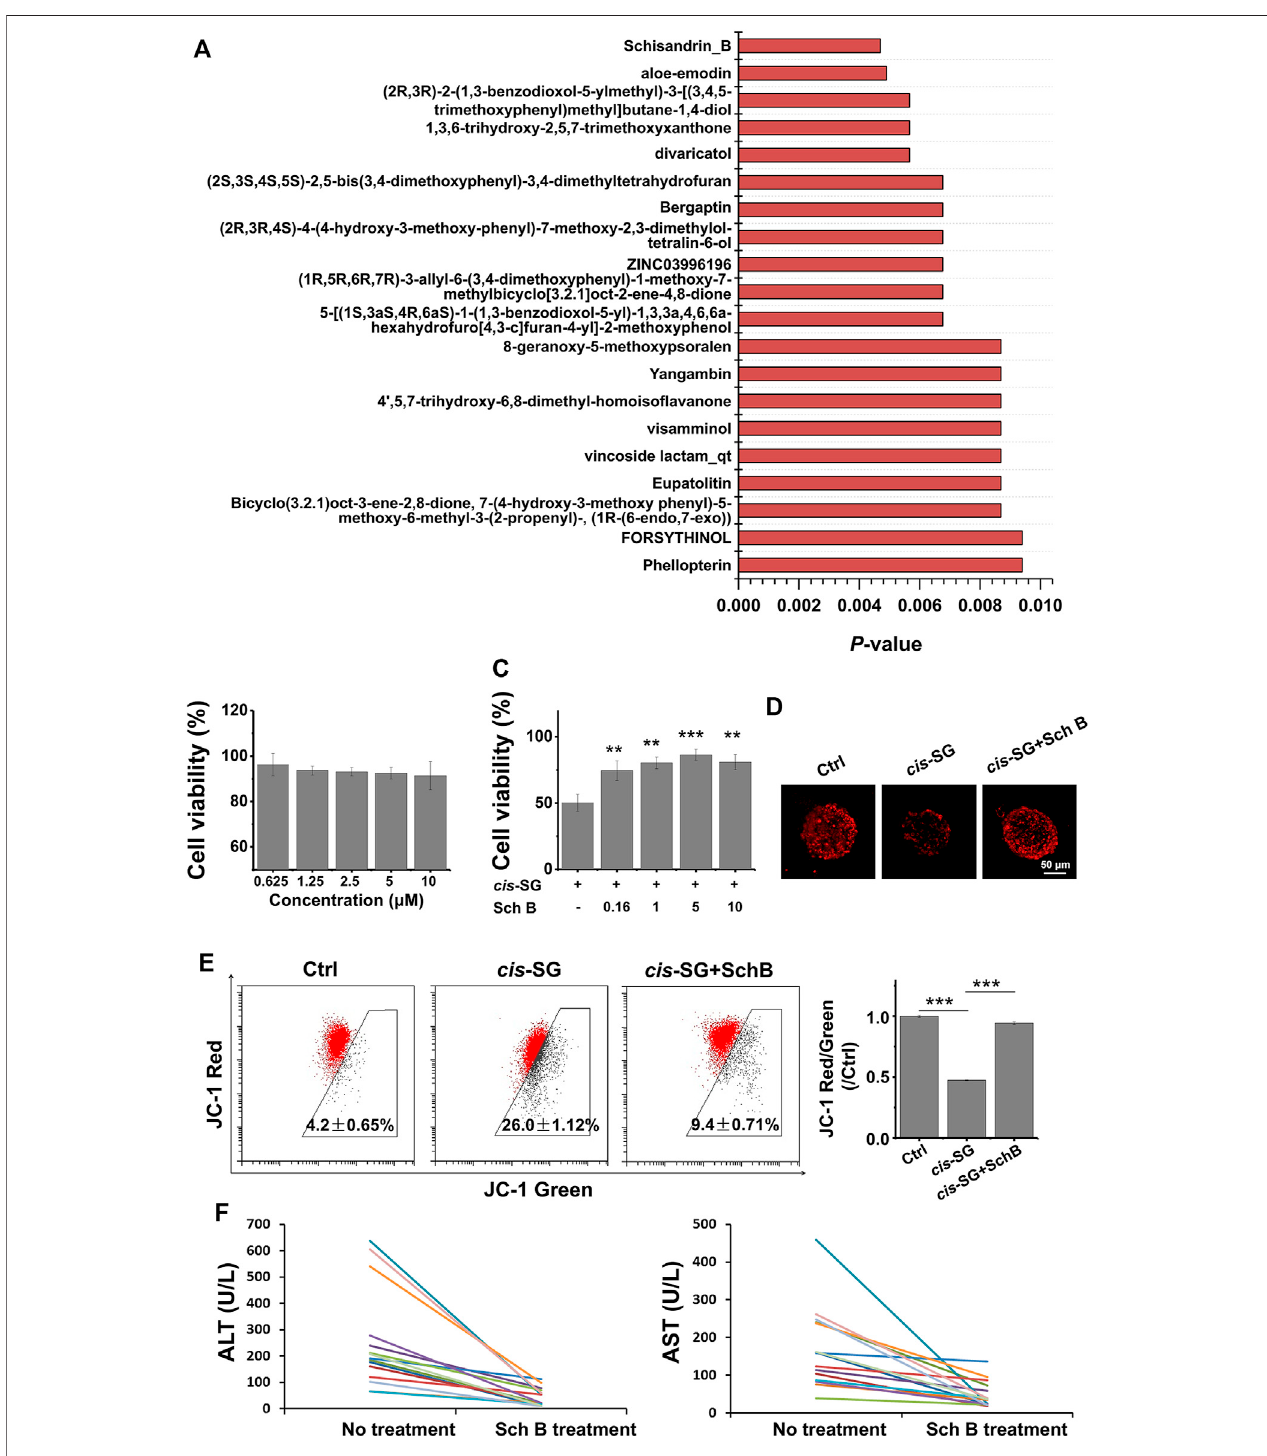
FIGURE 5 | Protective effects of the computer-screened mitochondria protective agent and its preparations against liver injury on organoids and patients. (A) The Top 20 mitochondrial protective compounds screened bycomputer-aided networkpharmacology approach from thenatural products database. (B) The cellviabilityof HepaRG cells after being only treated with Sch B for 24 h. (C) The HepaRG cell viability recovered after being co-treated with Sch B and cis-SG . (D) The mitochondrial staining images of cells treated with different groups. (E) The fl ow cytometric results of HepaRG cells stained with the MitoProbe ™ JC-1 Assay Kit, and the quanti fi ed ratio of JC-1 red fl uorescence intensity to green fl uorescence intensity, normalized to the control group. (F) Alleviation effect of the Chinese medicinal preparationscontainingSchBonpatientswith Polygonummulti fl orum – inducedliverinjuryindicatedbyserumALTandAST.Scalebar=50 μ m.Valuesareexpressedas mean ± SD. ** p < 0.01; *** p < 0.001.